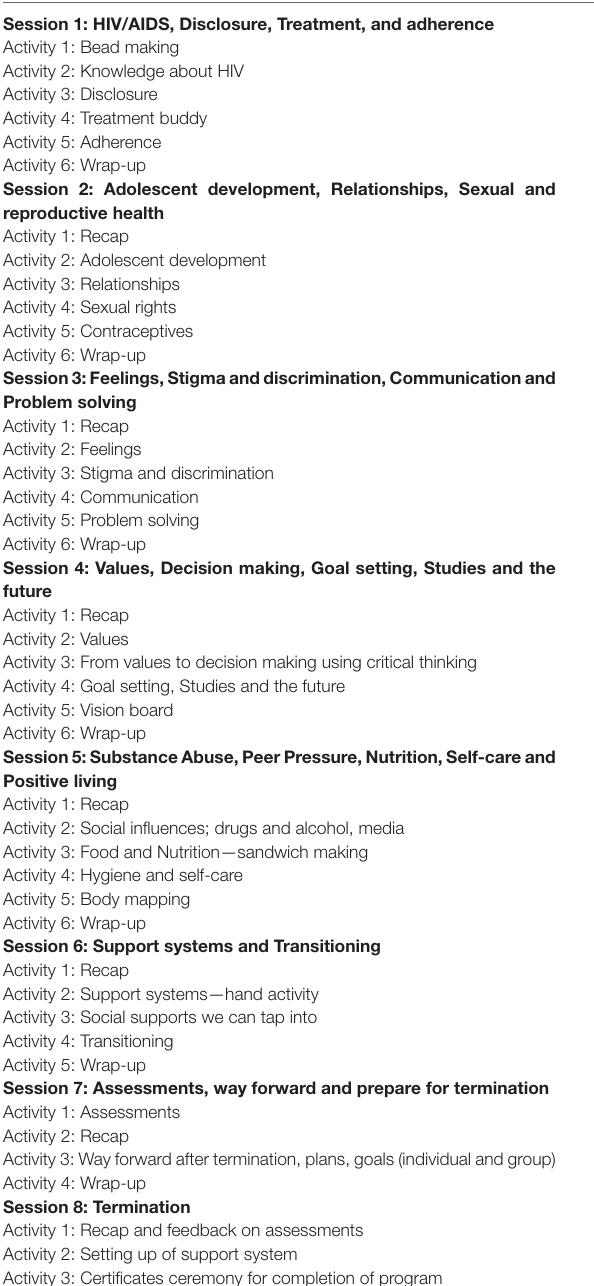
TABLE 2 | Overview of theme and